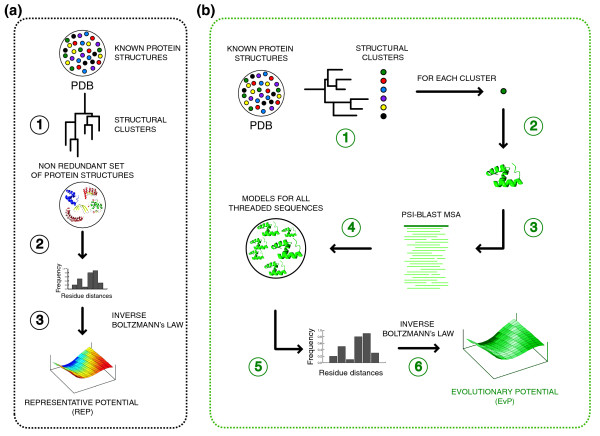
EvP and REP derivation protocols. (a) The REP potential was built in a three-step process to: step 1, generate a non-redundant set of protein structures from the PDB database; step 2, calculate all residue-residue distance frequencies within each of the representative chains from step 1; and step 3, derive a knowledge-based potential using the inverse Boltzmann law to transform the raw frequencies into pseudo-energy terms. (b) The EvPs were built in a six-step process to: step 1, generate a non-redundant set of protein structures from the PDB database; step 2, select each of the representative chains as query structures; step 3, calculate a MSA using the PSI-BLAST program; step 4, thread all homologous sequences into the query structure using the sequence-based alignment from the previous step; step 5, calculate all residue-residue distance frequencies; and step 6, derive a knowledge-based potential using the inverse Boltzmann law to transform the raw frequencies into pseudo-energy terms.